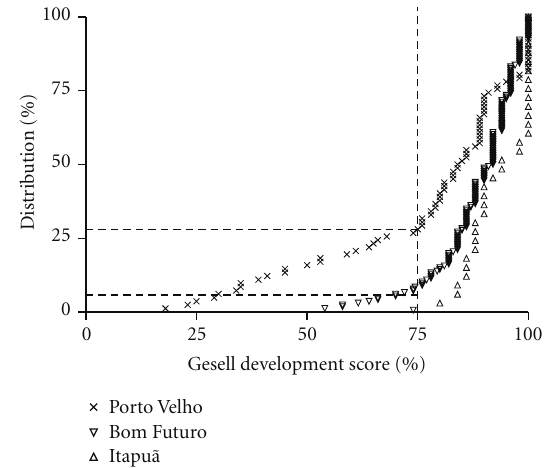
Figure 3: Cumulative percent distribution of infants’ neurological test at 6 months; Gesell total development